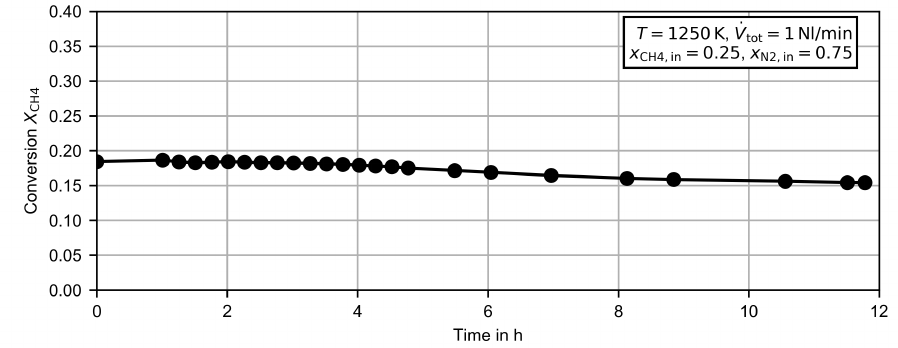
Figure 3. Methane conversion dependent on of the operation time for 25mol.% methane diluted in nitrogen at